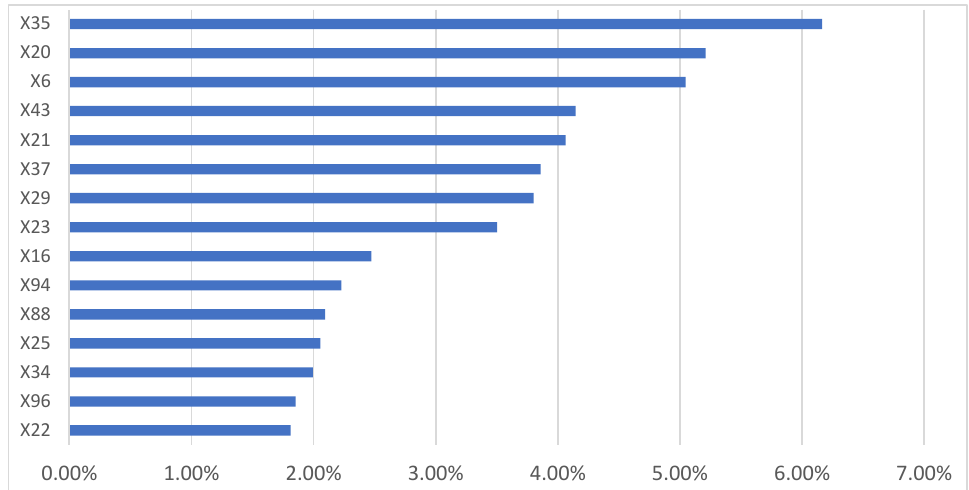
Figure 11. The 15 independent variables most influencing waste collection and disposal costs (variable = X1).